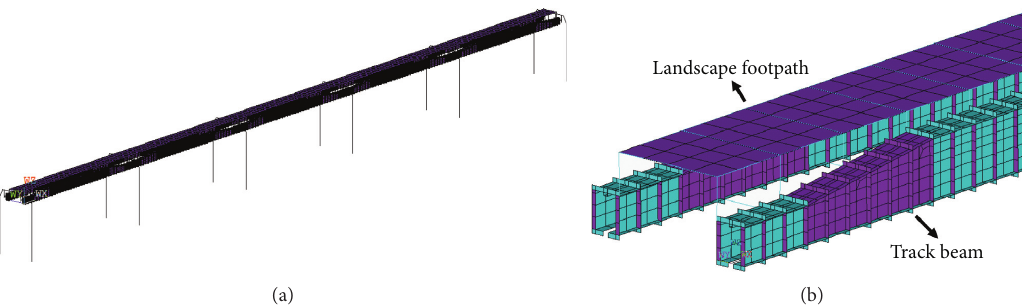
Figure 3: Finite element model of the suspension monorail system. (a) Full-bridge model. (b) Schematic diagram of the partial main beam